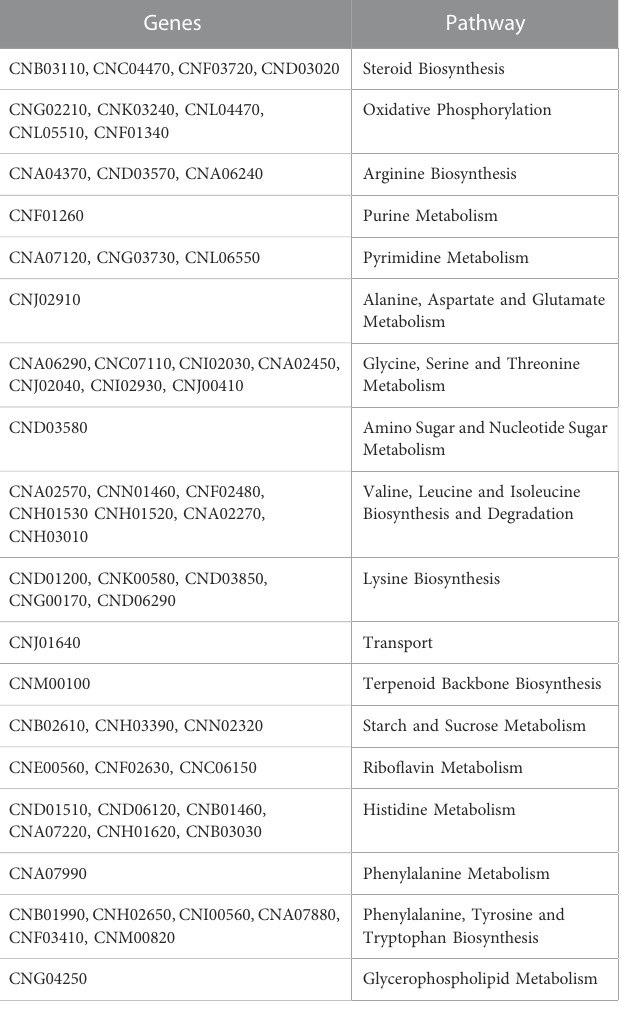
TABLE 2 The distribution of essential genes that do not have an ortholog in the human model. Genes